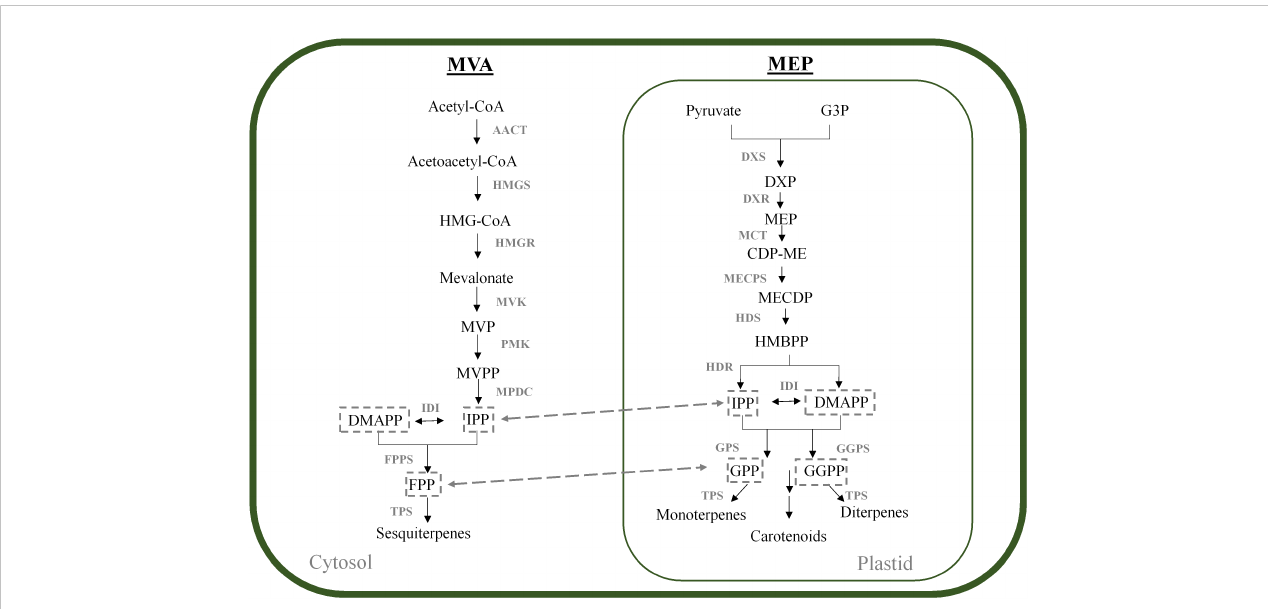
FIGURE 1 MVA and MEP pathways in plants. The MVA and MEP pathways forming the prenyldiphosphate precursor molecules for terpene synthesis are shown in the cytosol and plastid, respectively. Downstream metabolites are indicated. AACT, acetyl-CoA acetyltransferase; CDP-ME, 4-diphosphocytidyl-2-C- methyl-D-erythritol; CDP-MEP, CDPME 2-phosphate; CMK, 4-(cytidine 5 ′ -diphospho)-2-C-methyl-D-erythritol kinase; DMAPP, dimethyl allyl diphosphate; DXP, 1-deoxy-D-xylulose 5-phosphate; DXS, DXP synthase; DXR, 1-deoxy-D-xylulose 5-phosphate reductoisomerase; FPP, farnesyl diphosphate; FPPS, FPP synthase; G3P, glyceraldehyde 3-phosphate; GGPP, geranylgeranyl diphosphate; GGPPS, GGPP synthase; GPP, geranyl diphosphate; GPPS, GPP synthase; HDR, hydroxymethylbutenyl diphosphate reductase; HDS, 4-hydroxy-3-methylbut-2-en-1-yl diphosphate synthase; HMBPP, ( E )-4-hydroxy-3-methylbut-2-en-1-yl diphosphate; HMG-CoA, hydroxymethylglutaryl-CoA; HMGR, HMG-CoA reductase; HMGS, HMG-CoA synthase; IDI, isopentenyl pyrophosphate isomerase; IPP, isopentenyl diphosphate; MCT, 2-C-methyl-D-erythritol 4-phosphate cytidylyltransferase; MECPD, 2-C-methyl-D-erythritol 2,4-cyclodiphosphate; MECPS, MECPD synthase; MVK, mevalonate kinase; MPDC, mevalonate diphosphate decarboxylase; MVP, mevalonate 5-phosphate; MVPP, mevalonate 5- pyrophosphate; PMK, phosphomevalonate kinase; TPS, terpene